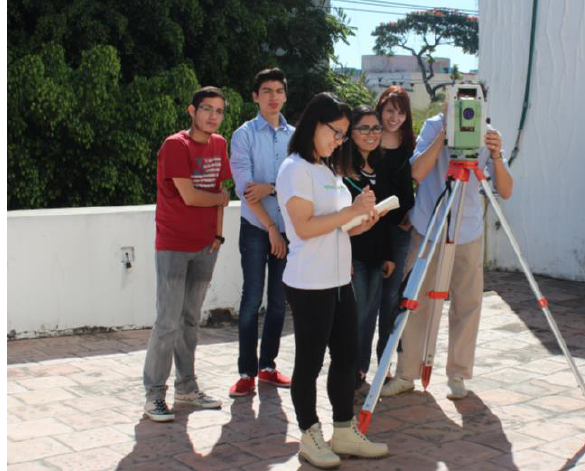
Fig. 8 Surveying phase working with the Leica Geosystems Total Station TS11. Photo’s author: Mario Santana